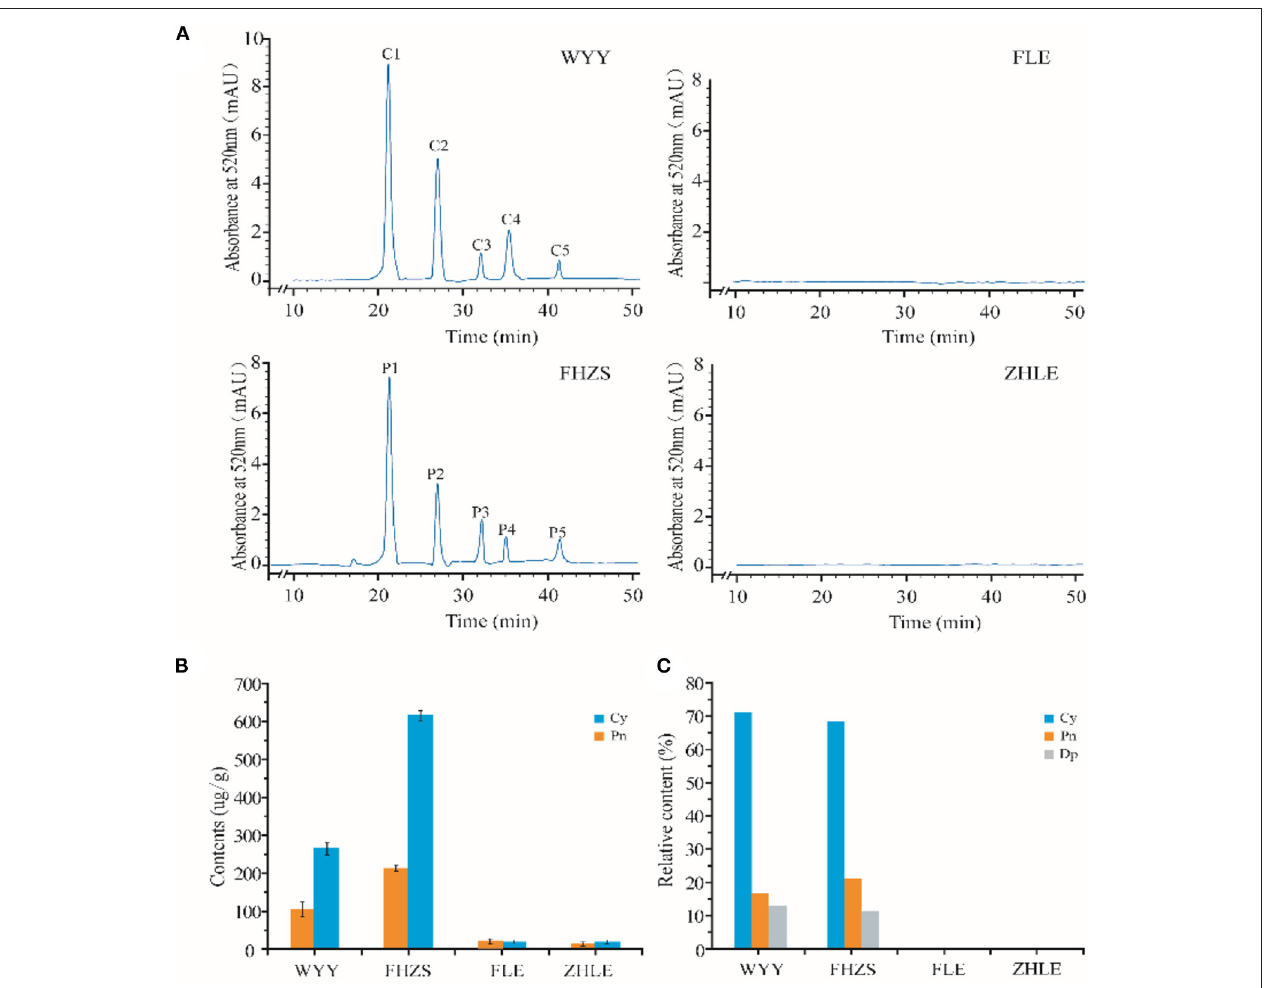
FIGURE 2 | HPLC-MS analysis of pigmentation in stems. (A) Results of anthocyanins composition in mei cultivars with different stem colors by HPLC-MS analysis. (B) The absolute quantification of anthocyanins content in four mei cultivars. (C) The relative quantification of anthocyanins content in four mei cultivars. WYY and FHZS were red stem cultivars, FLE, and ZHLE were green stem